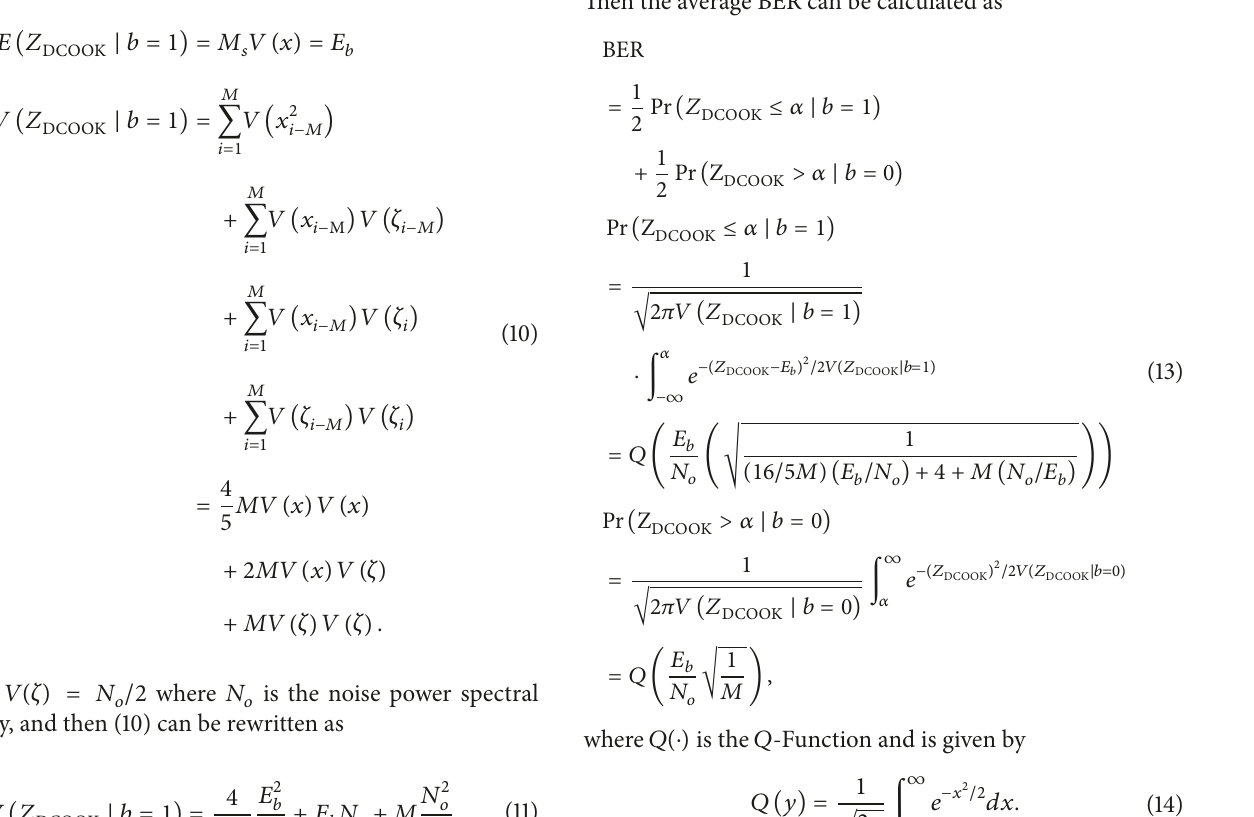
Similarly, we can